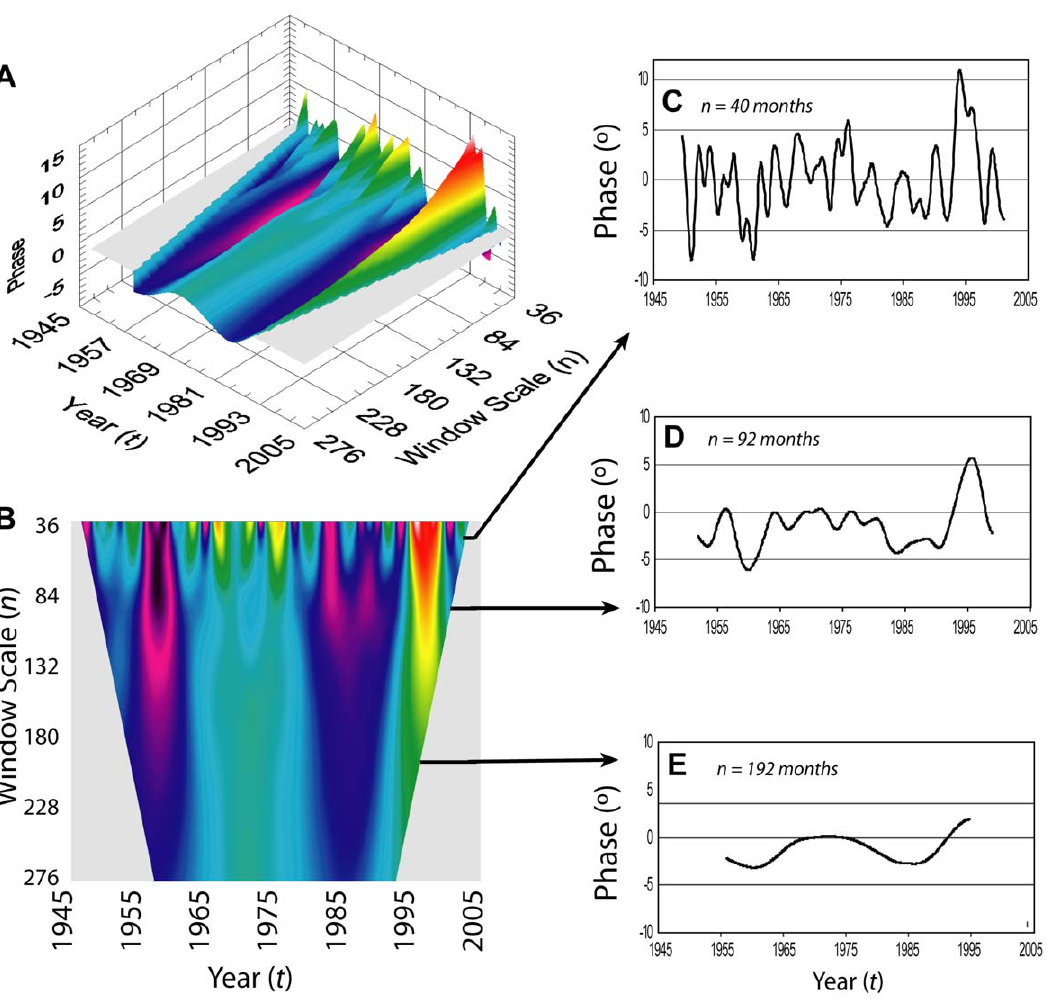
Figure 2. The values of W ( t , n ) over a range of frequency scales and across the time series from 1948 to 2004. (A and B) Assembled values of W ( t , n ) from long term Lake Baikal surface temperature time series over the period 1948 to 2003 and window sizes ( n ) 36 to 276 months. Cooler colors are more negative W ( t ,n); warmer colors are more positive W ( t , n ); if phase were a constant, the surface would be flat. The surface tapers with increasing n as W ( t , n ) is referenced to the center of the window of length n , and as n increases there is an increasing n /2-long segment that does not have a relevant measure of W ( t , n ) at the beginning and end of the time series. (C, D and E) Time series of W ( t , n ) sampled at n equal 40 (C), 92 (D) and 192 (E) months. Estimating W ( t , n ) at longer n averages over a longer time and is equivalent to smoothing the low n W ( t , n ) time series. As such W ( t , n ) at lower values of n captures temperature anomalies occurring at higher frequencies and vice versa.